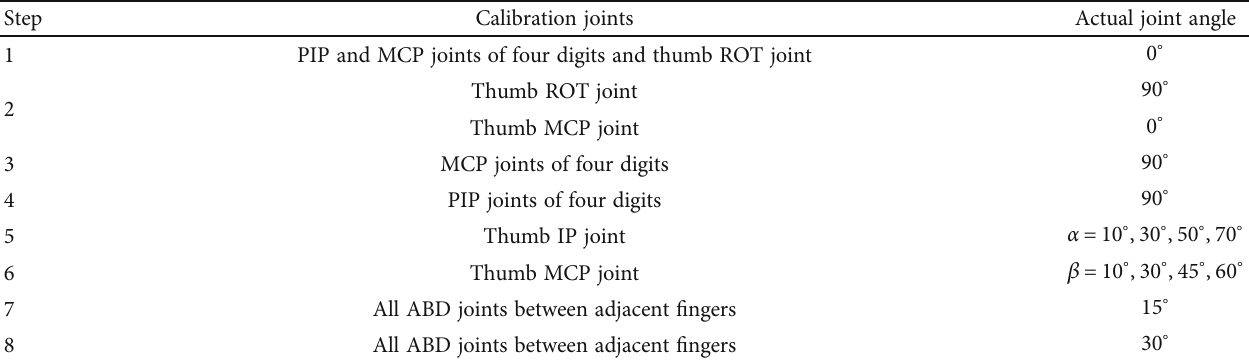
Table 3: The calibration joints and actual joint angles in each calibration